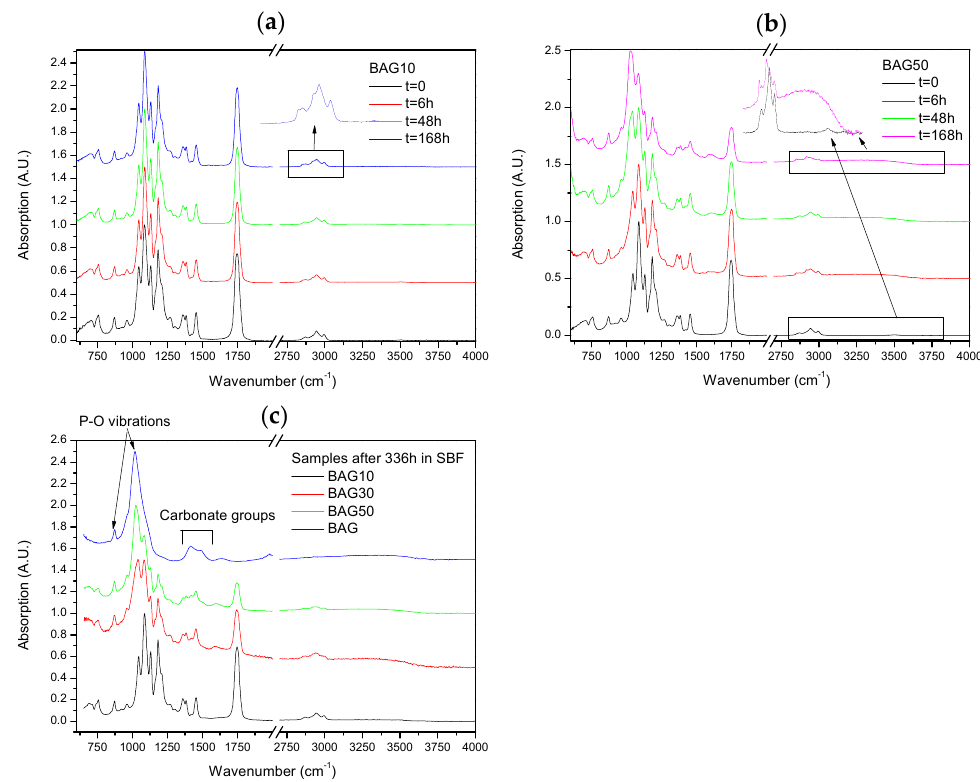
Figure 6. FTIR–ATR spectra of the composites labelled BAG10 ( a ) and BAG50 ( b ) at various immersion times and of all composites immersed for 336 h ( c ). In addition, the FTIR spectra of immersed bioactive glass alone in SBF for one week has been added Figure 6c to show the formation of the HA layer at the surface of the glass particles.